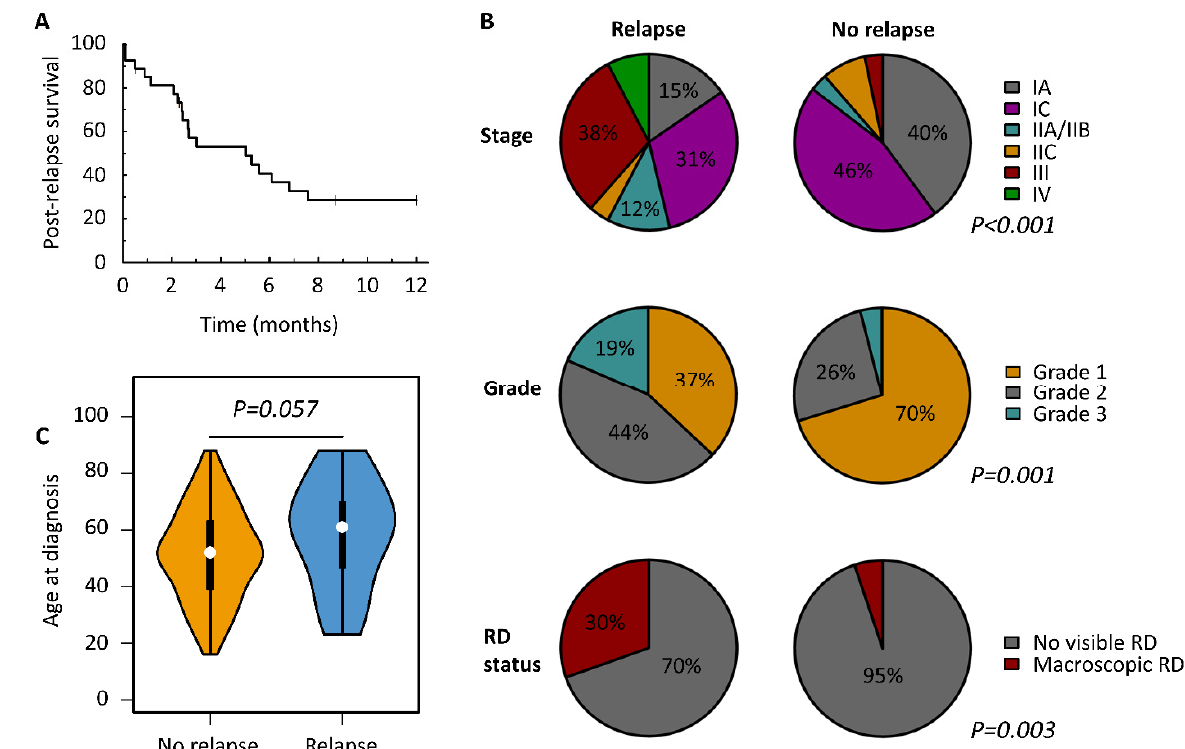
Figure 3. Characteristics of relapsed mucinous ovarian carcinoma. ( A ) Overall post-relapse survival. ( B ) Clinicopathological features at diagnosis in cases who subsequently experienced relapse versus those relapse free at last follow-up; ( C ) violin plot of age at diagnosis between relapsed cases and cases that that were relapse free at last follow-up. Table 2. Survival analysis of mucinous ovarian carcinoma patients.